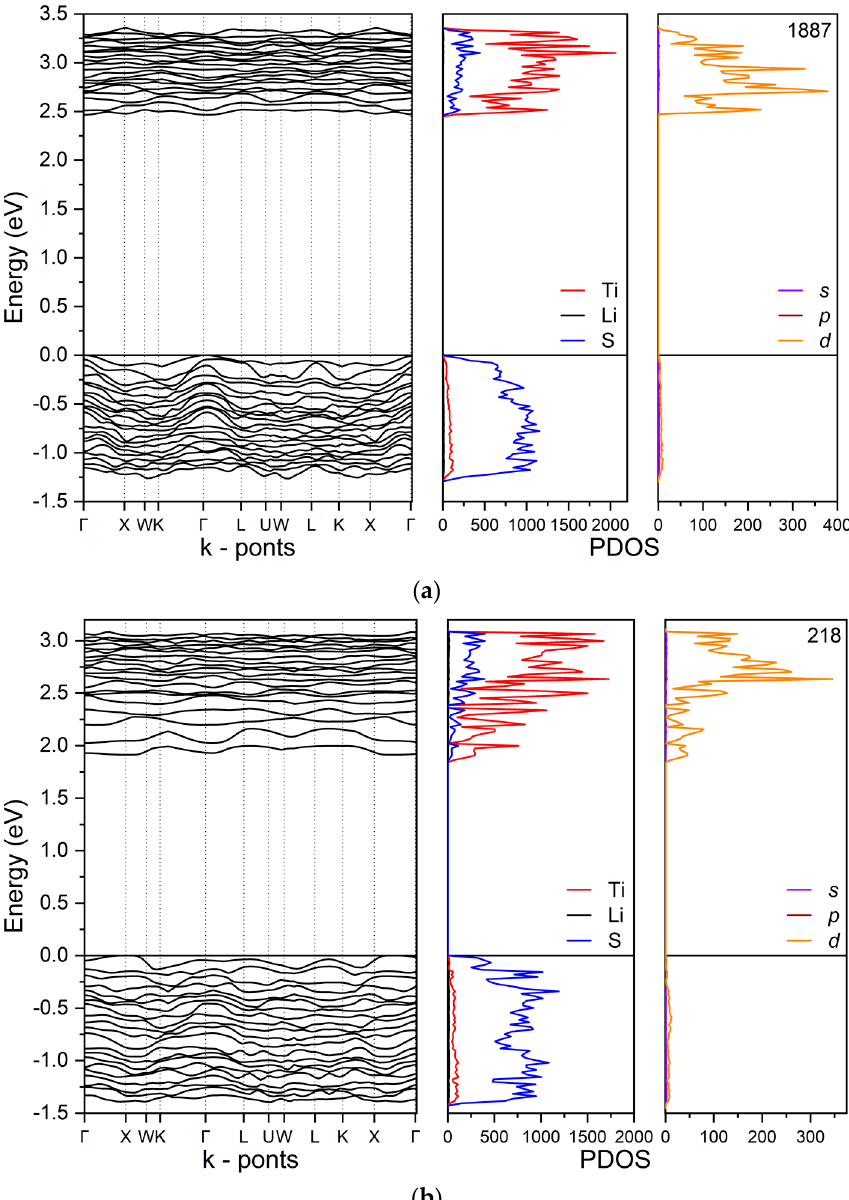
Figure 5. Band Structure and PDOS of pseudocubic “dispersed” structures 1887 ( a ) and “ordered” 218 ( b ). Ti, S, and Li projections are reported in the middle panels of ( a , b ). In the right panels 4s, 4p, and 3d projection over a single Ti atom are reported. In the case of structure 218 the Ti atom is one from the Ti row. See also Figure 4 and Table 4.